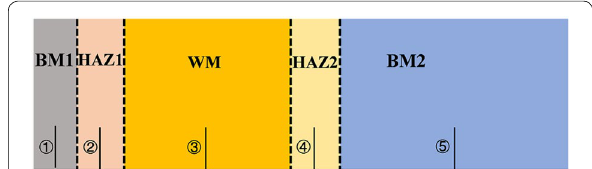
Figure 2 Crack locations in SENB specimens in experiments